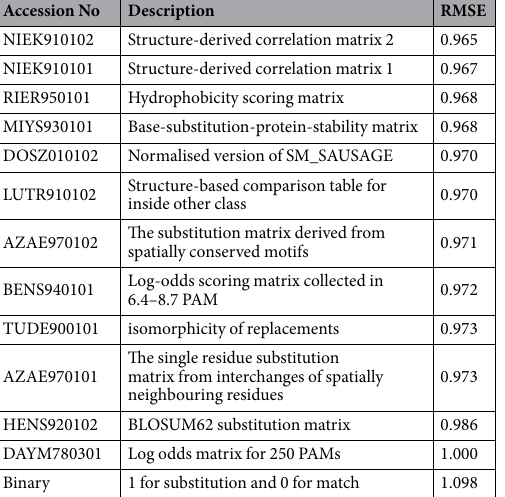
Table 1. The top 12 amino acids substitution matrices in predicting influenza